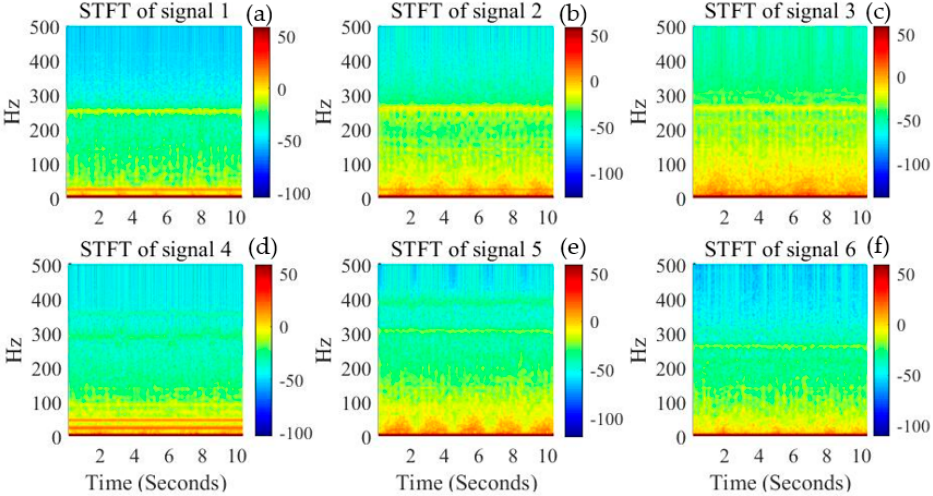
Figure 3. STFT of different weak signals. ( a ) STFT of signal 1; ( b ) STFT of signal 2; ( c ) STFT of signal 3; ( d ) STFT of signal 4; ( e ) STFT of signal 5; ( f ) STFT of signal 6.